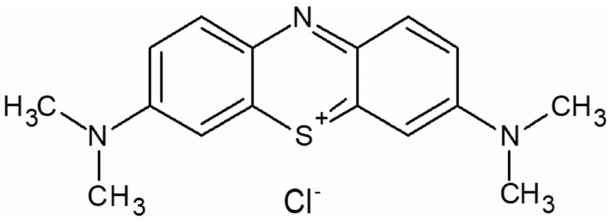
Figure 1. Structure of methylene blue (MB).